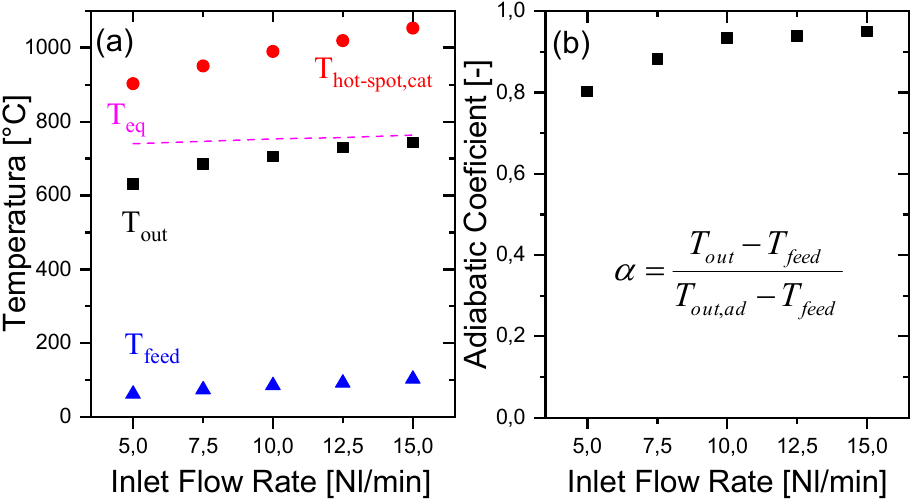
Figure 3. Effect of flow rate. Flow rate: ( a ) adiabaticity coefficient and ( b ) temperatures. Feed composition: iC8 = 3%, air with C / O = 0.9 and N 2 complement.